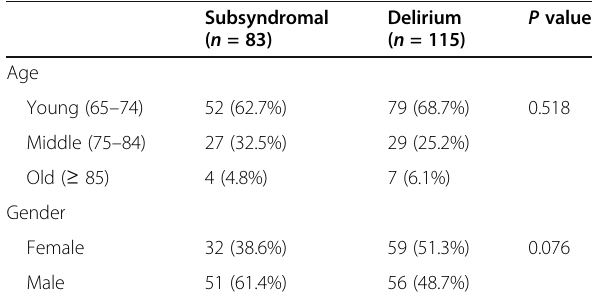
Table 1 Demographic data of delirium and SSD patients